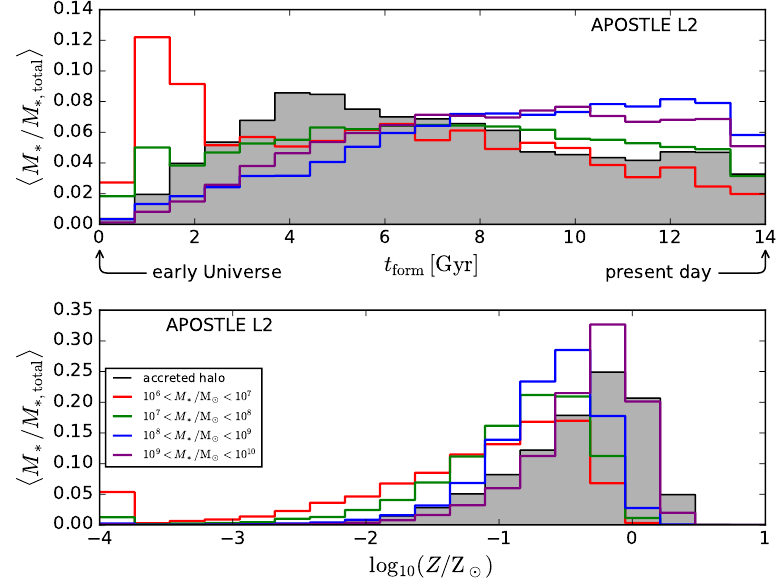
Figure 1. The upper panel shows the formation time distribution for stars in the accreted halos of the 24 Milky Way (MW)- and M 31-like galaxies from the APOSTLE simulation suite (filled histogram) at resolution level L2. The coloured lines show the same distribution for field (central) objects in 4 consecutive 1-dex bins of stellar mass from 10 6 to 10 10 M (cid:12) (red, green, blue, purple in order of increasing M (cid:63) ). The lower panel shows the metallicity distribution for the same classes of objects. The accreted halos have a metallicity distribution similar to that of 10 9 –10 10 M (cid:12) field objects, but relatively older stellar populations. For all curves, star particles with metallicities < − 4 contribute to the lowest metallicity bin